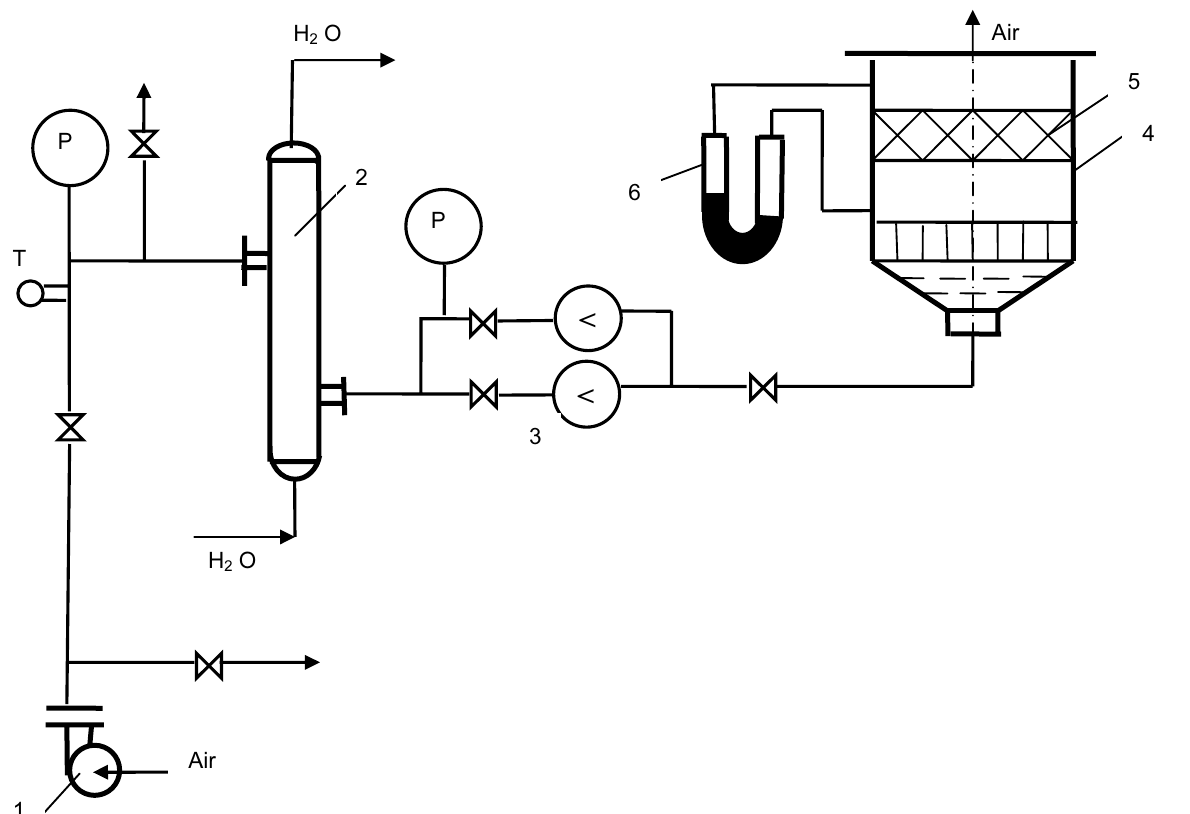
Fig 3. Scheme of experimental equipment: 1 – air tank; 2 – heater; 3 – diaphragms; 4 – cylinder mechanism Ø 100 mm; 5 – block of high porosity material sedimentation; 6 – difmanometer